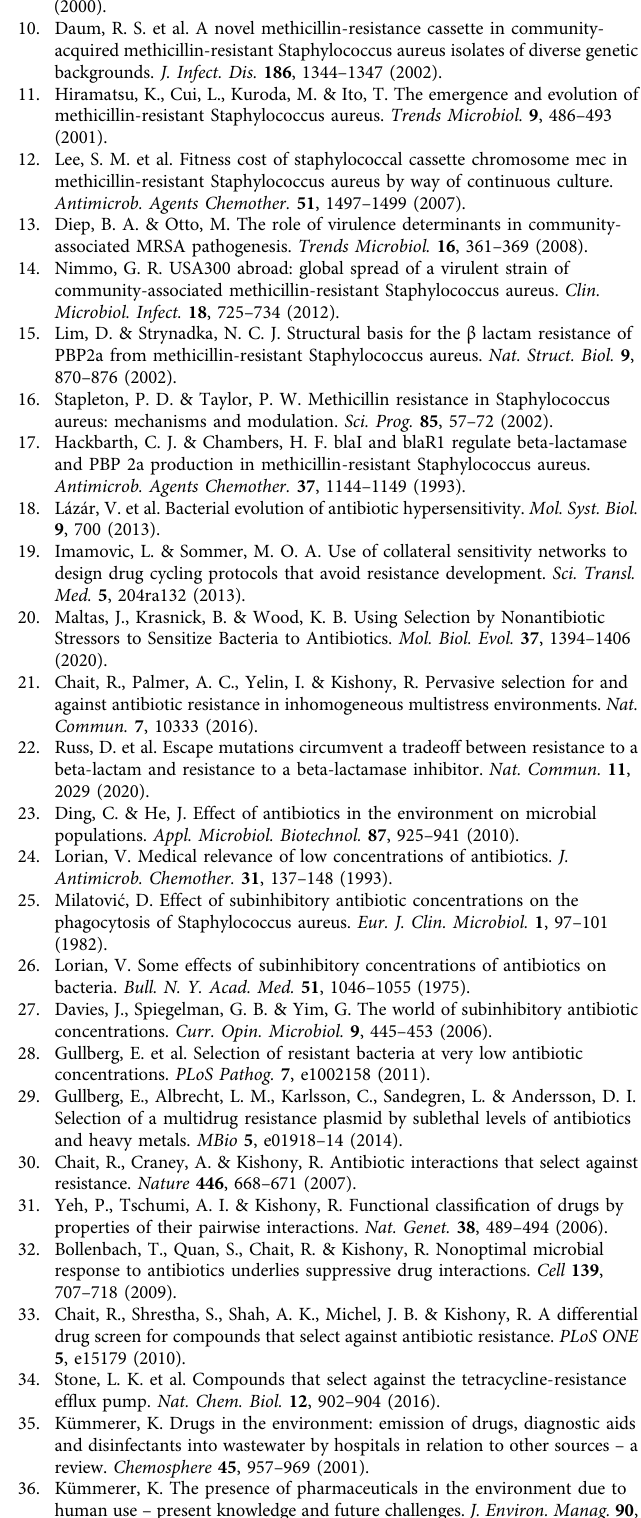
(Supplementary Fig. 12 for all cumulative distributions, Supplementary Data 3 for statistics). After assessing multicollinearity with variance in fl ation factor (VIF), variables showing no multicollinearity and having P ≤ 0.1 were entered into the logistic regression model. We performed logistic regression via the MATLAB fi tglm